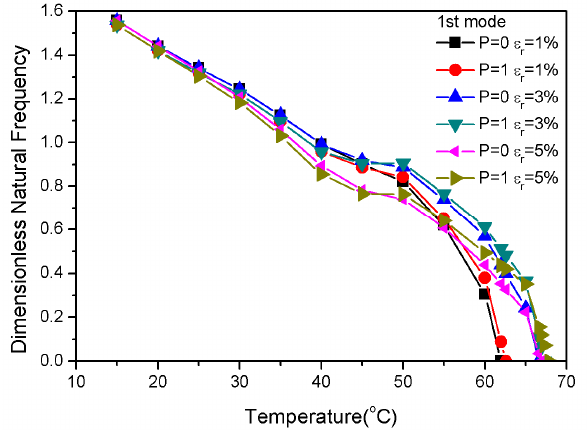
Figure 7. Dimensionless natural frequencies vs. temperature with variations of pre ‐